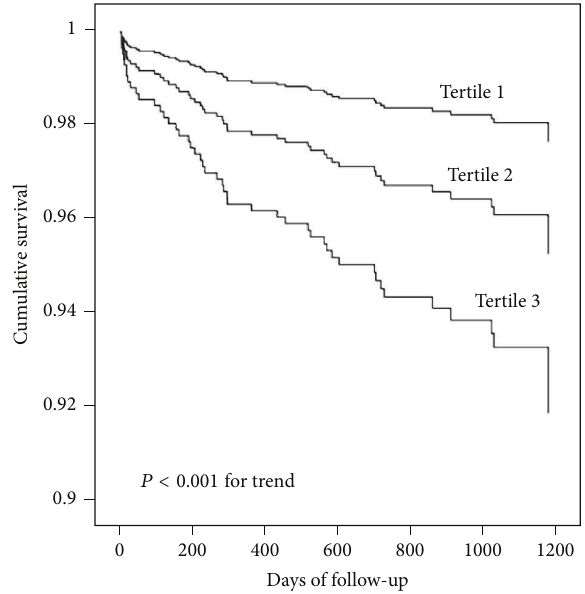
Figure 1: Kaplan-Meier hazard plots for all-cause mortality by tertiles of interleukin-6. The probability values represent the trend across all three tertiles.